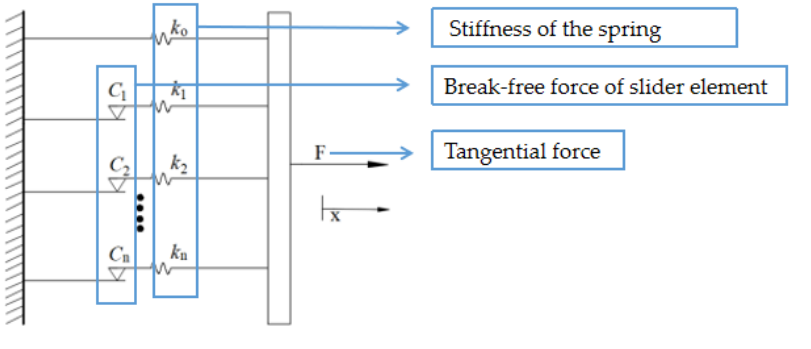
Figure 16. Iwan Figure 16. Iwan model.